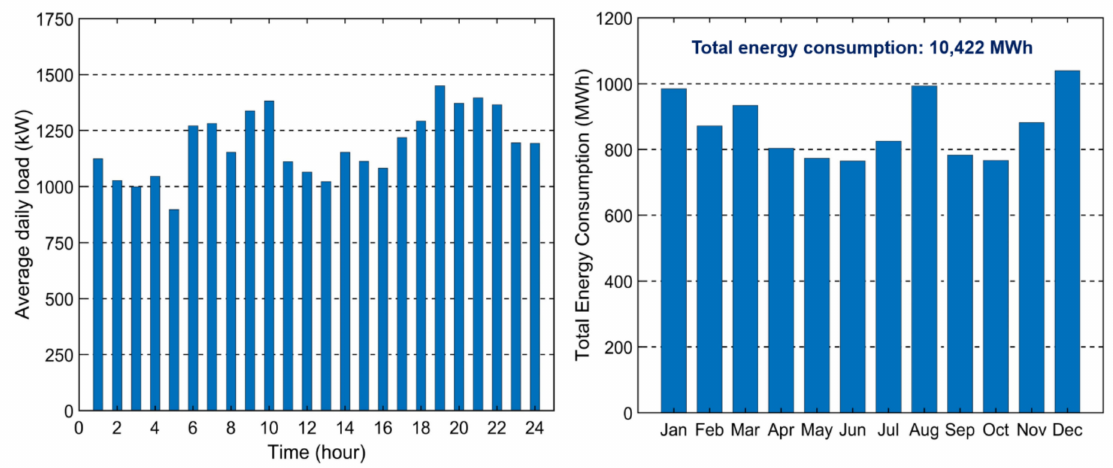
Figure 14. The average daily load profile and monthly energy consumption of Deokjeok